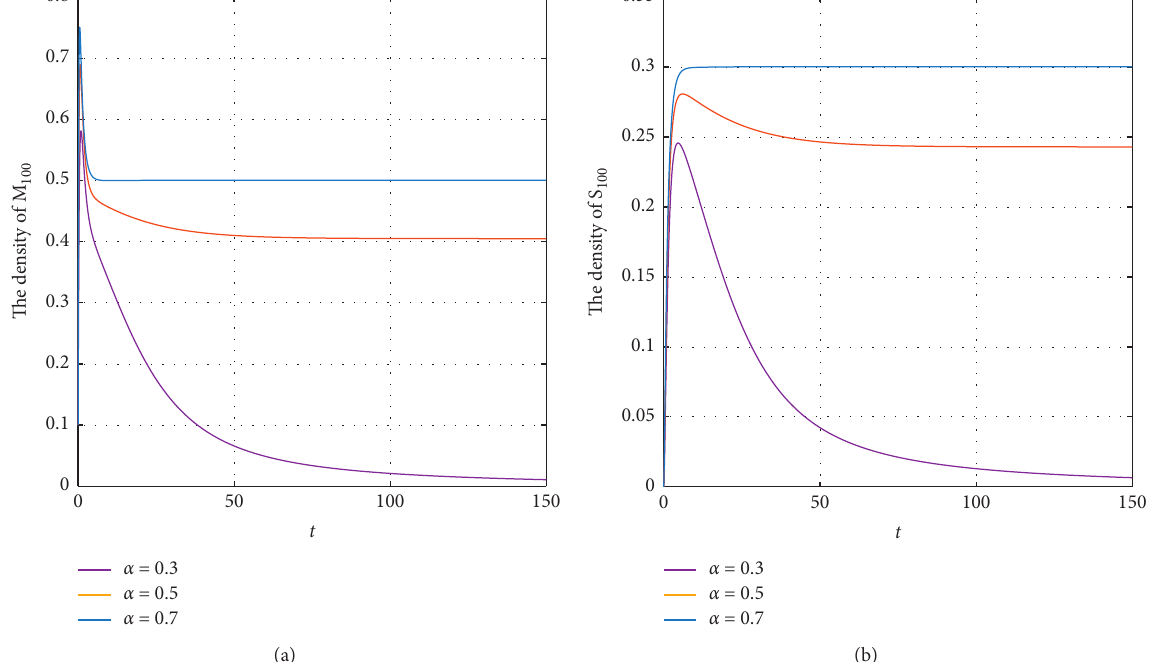
and S versus t to different α with R 100 100